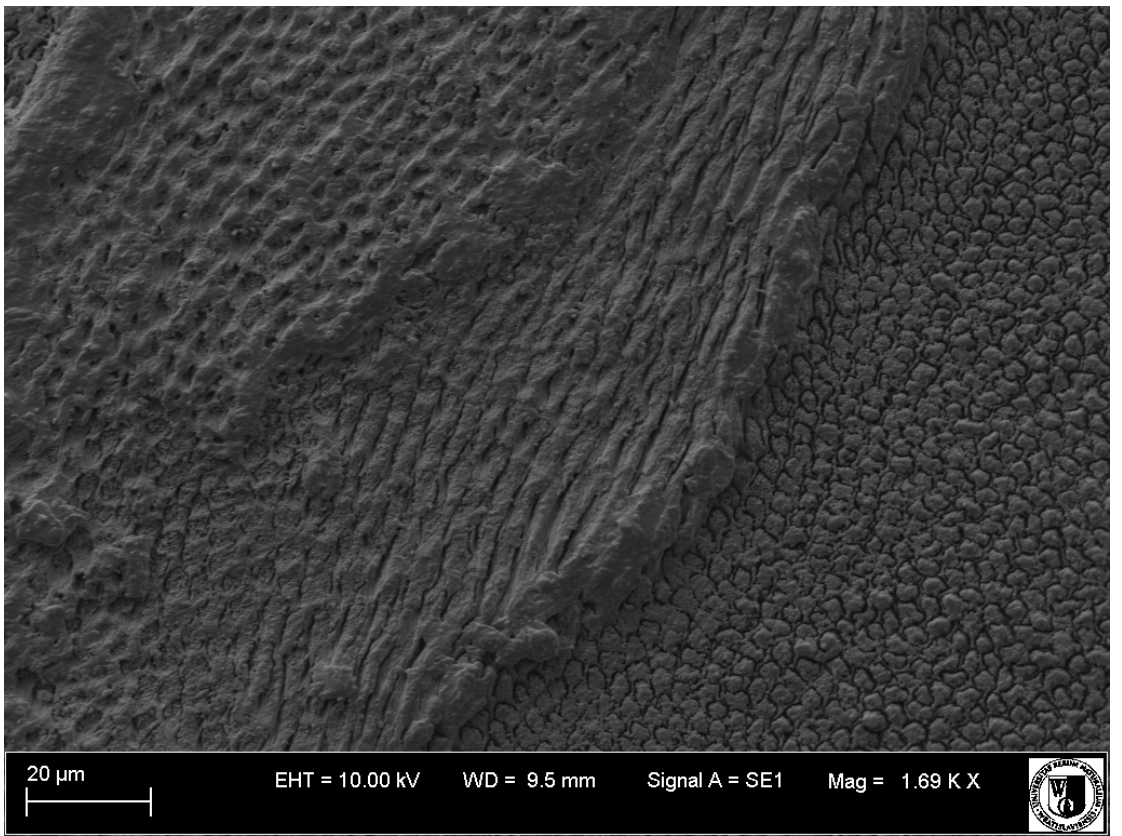
Figure 14. SEM micrograph of enamel (horizontal section through the crown), view of prisms—oblique (central) and vertical (right) on the third premolar (P 3 ) of the white rhinoceros female.